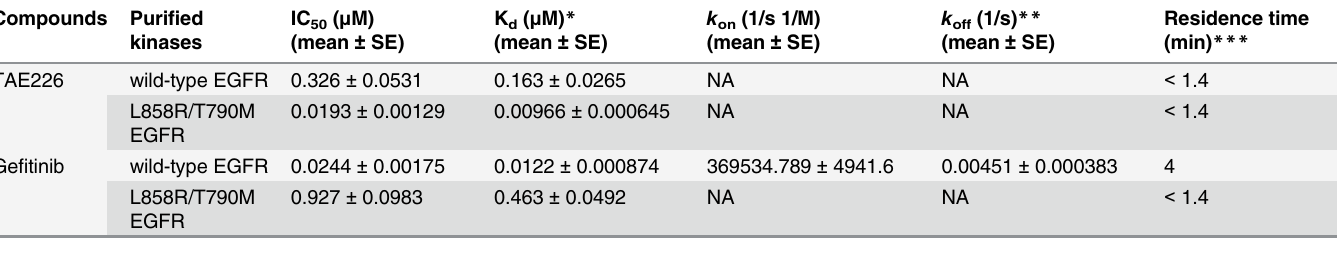
Table 2. IC 50 values by kinetic interaction analysis of TAE226 and gefitinib against wild-type EGFR and L858R/T790M EGFR mutant. Compounds Puri fi ed IC 50 ( μ M) (mean ± kinases